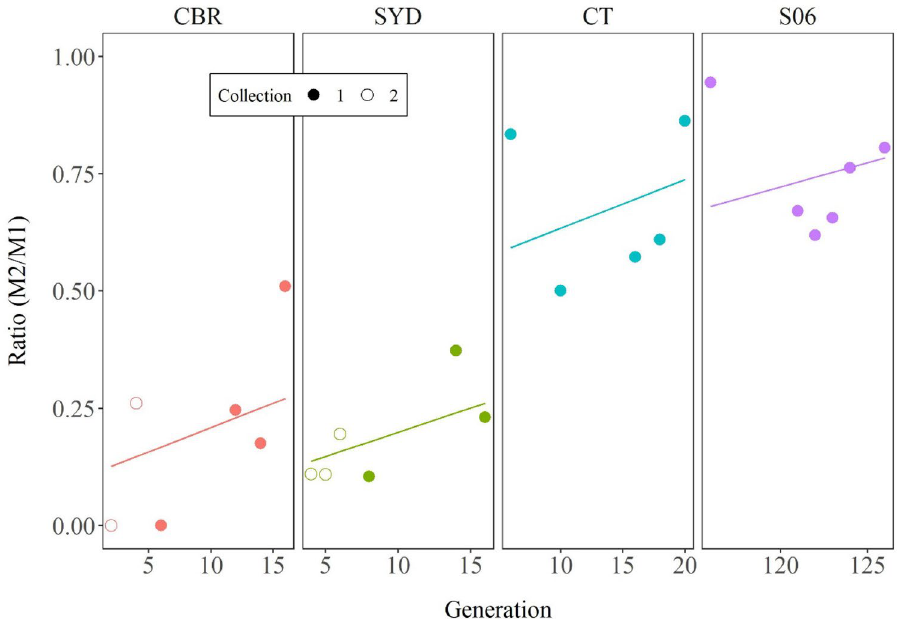
Figure 4. Changes in the M2%/M1% ratio for the three wild/caught populations and S06 over generations in Experiment 1. The data for different populations and the -1 and -2 SYD and CBR collections are shown with different colours and symbols respectively, as per Fig. 3. Lines of best fit for each population across generations are also